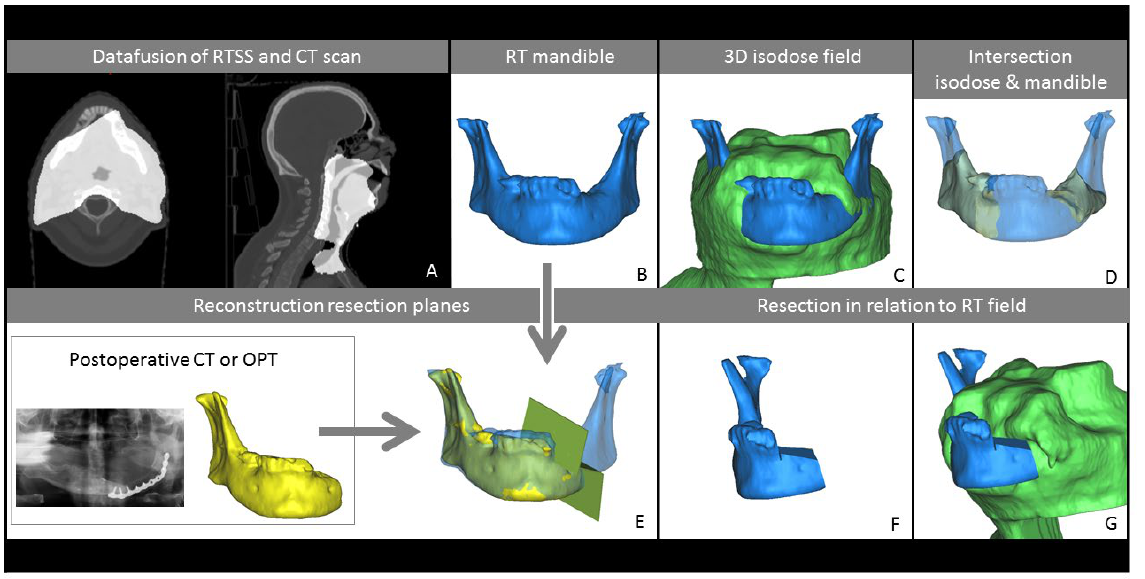
Figure 1. Describing the workflow of data fusion and segmentation, including reconstruction of the performed segmental resection. ( A ). Data fusion of radiotherapy planning files (RTSS) and RT CT scan. ( B ). 3D model of the mandible from RT CT scan. ( C ). In green, the 3D reconstruction of the 56Gy isodose volume. ( D ). In yellow, the volume of the mandible radiated with 56Gy (Vm56). ( E ). Reconstruction of performed segmental resection using either a postoperative CT or OPT. ( F ). Mandible after segmental resection. ( G ). Mandible after segmental resection in relation to the 56Gy isodose volume (V56).